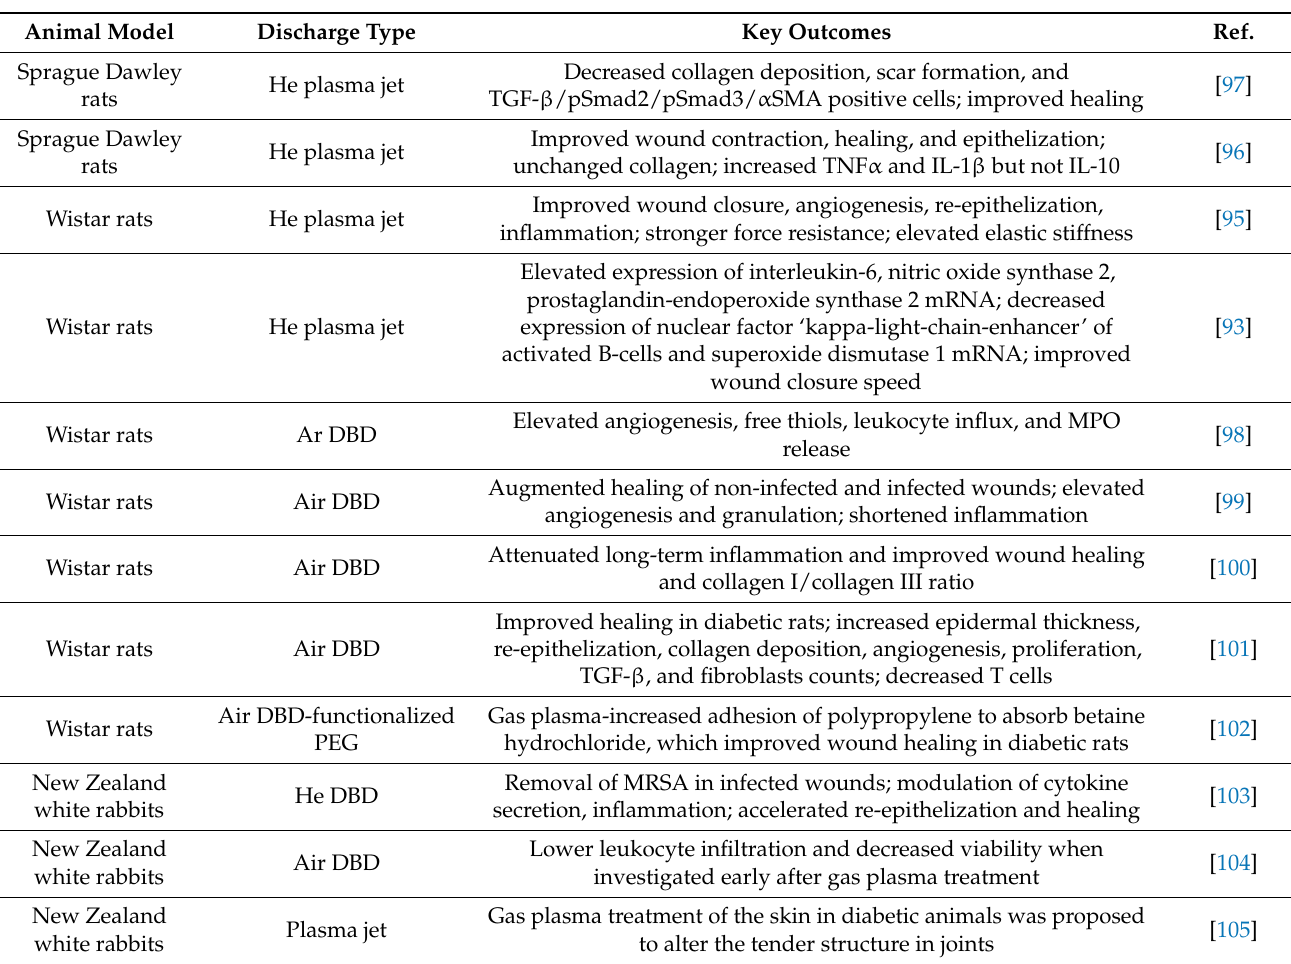
Table 2. Cont. Key Outcomes